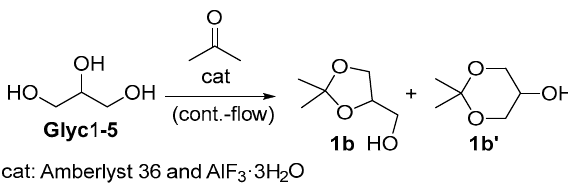
Figure 2. CF-reaction of glycerol with acetone over AlF 3 ·3H 2 O. ( A ) Profile of the glycerol conversion vs. temperature obtained at 10 bar, after 24 h, with the use of Glyc3 as the reagent; ( B ) Conversion of glycerol achieved after 24 h, at 100 °C and 10 bar, by feeding different types of reactant Glyc1-5 to the reactor; ( C ) Effect of T and p on the conversion of Glyc5 achieved after 24 h. In all cases, WHSV = 2 was used. The molar ratio acetone:glycerol was 40 and 4 for Glyc1 and Glyc2-5 , respectively.